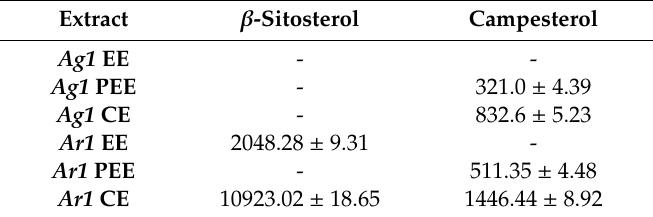
Table 3. The content in sterols in A. genevensis (Ag1) and A. reptans (Ar1) extracts ( µ g / mL extract). Extract β -Sitosterol